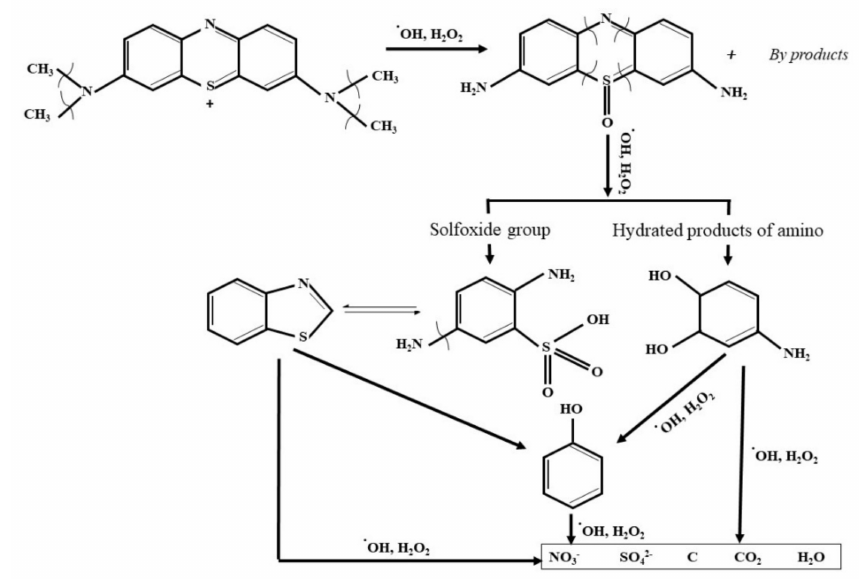
Figure 15. Possible degradation mechanism of